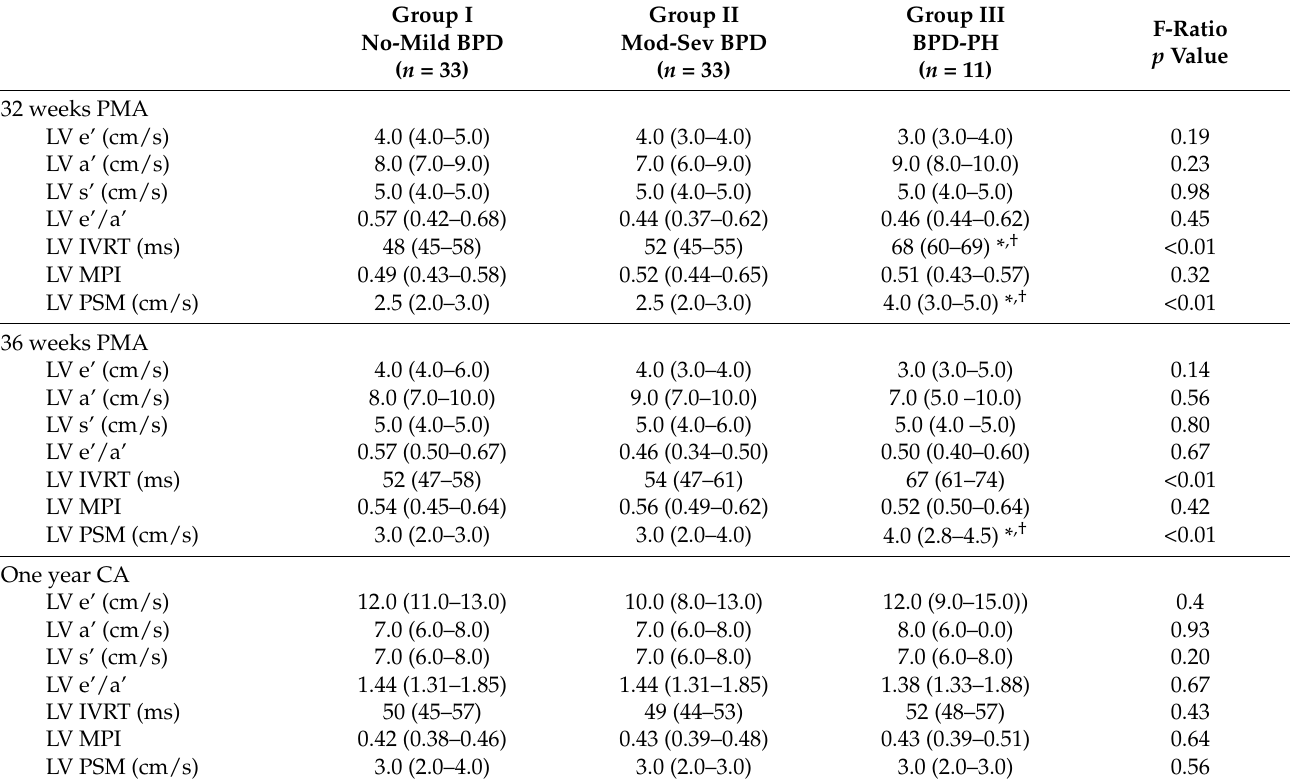
Table 3. LV tissue Doppler indices at the lateral side of the mitral valve